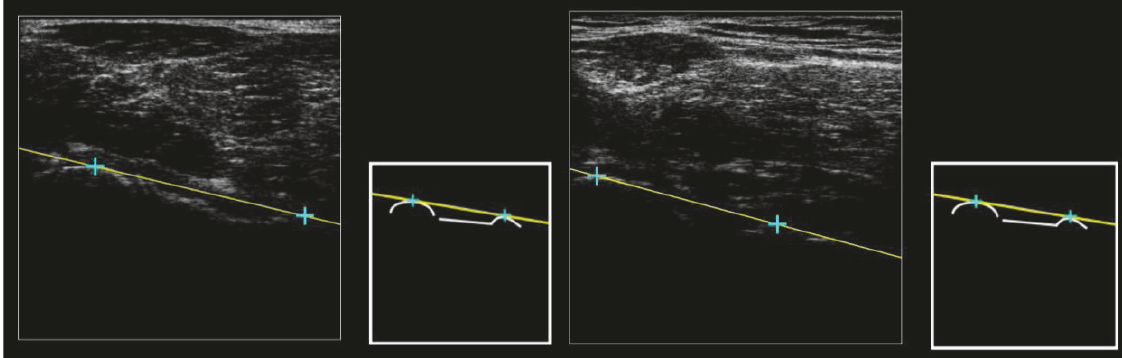
Figure 1: Ultrasound images of the femoral neck for subject S001 (left) and subject S002 (right) with the two points palpated in the immediate postprocessing to determine the femur neck axis. All nine landmarks which were found by the operator are guided by a pattern which is displayed to the right of the ultrasound feed. The guide is shown without the lines/points during the measurement process and with the lines/points in the immediate postprocessing (shown above in both